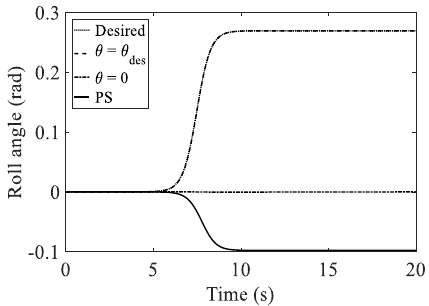
Figure 6. Roll angle of the vehicle body.